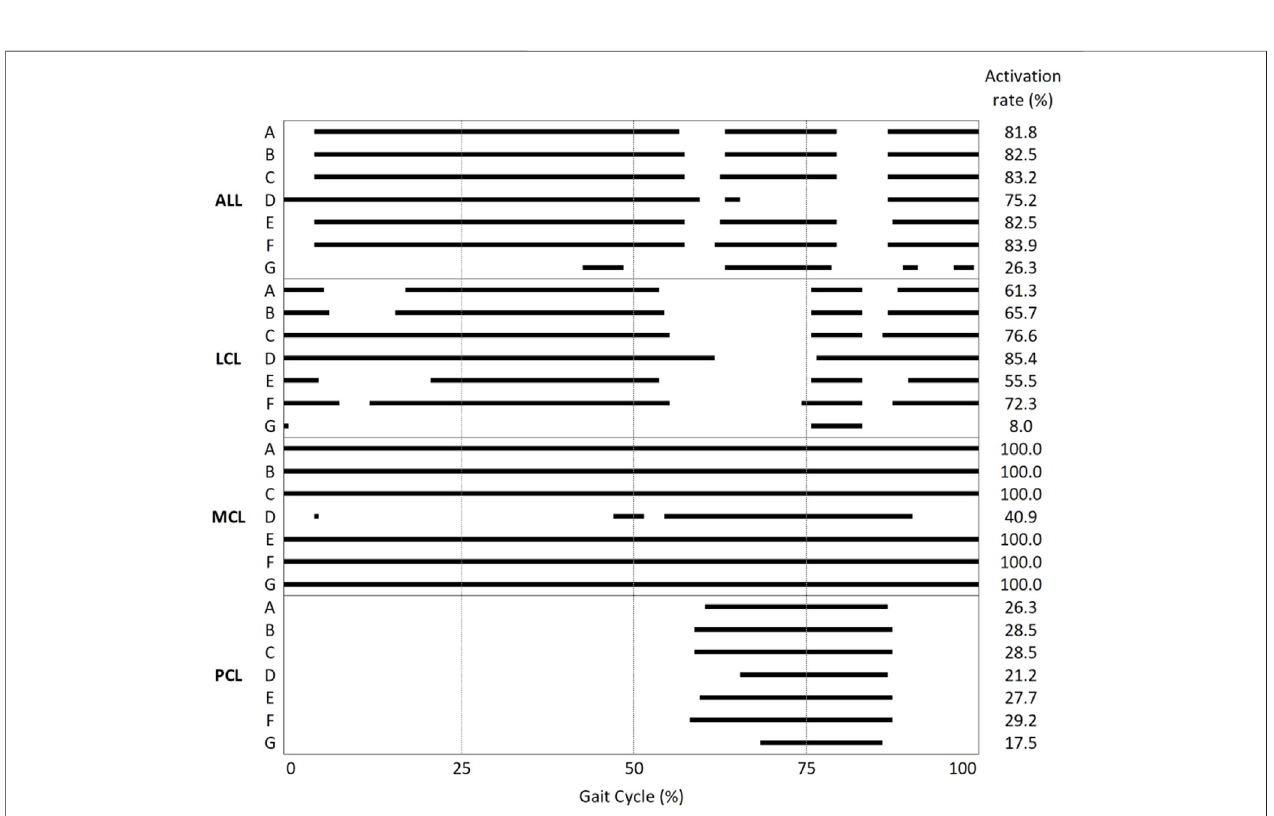
FIGURE 7 | Activation/deactivation point and activation rate during the gait cycle of the ALL, LCL, MCL, and PCL in models A – G.